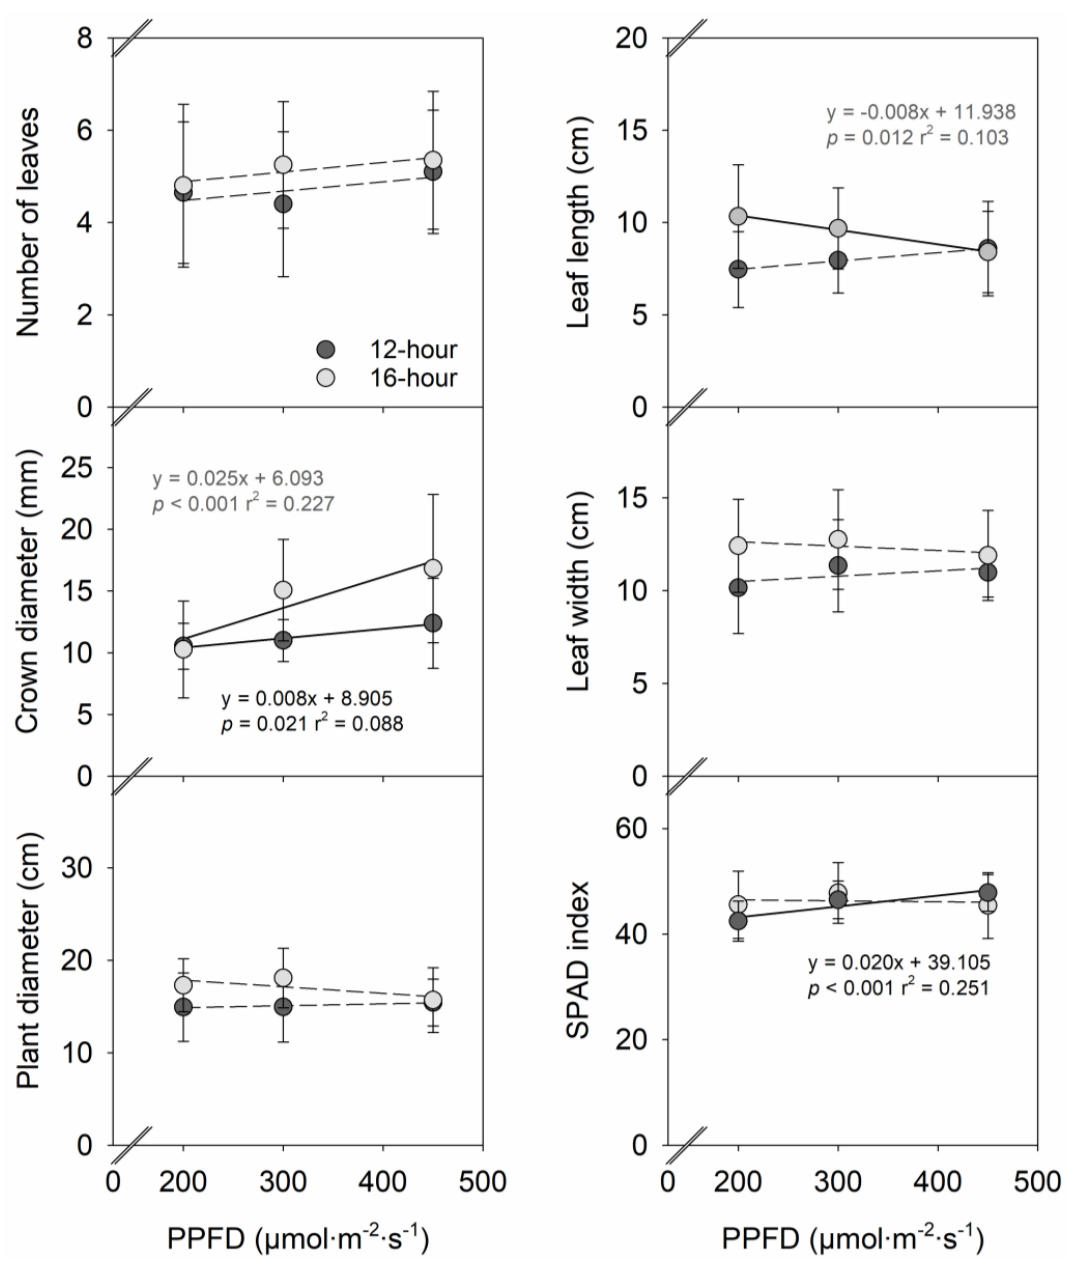
Figure 1. Influences of photosynthetic photon flux density (PPFD) of sole-source lighting treatments on plant growth characteristics of strawberry ‘Albion’ grown under a 12-h or 16-h photoperiod. Each data point represents the mean and standard deviation of two replications with 10 subsamples (plants) per replication (n = 20). Regression equations, coefficient of determination (r 2 ), and p values are presented when the linear relationship with PPFD is statistically significant at p < 0.05 (solid line), but not when insignificant (dashed line).